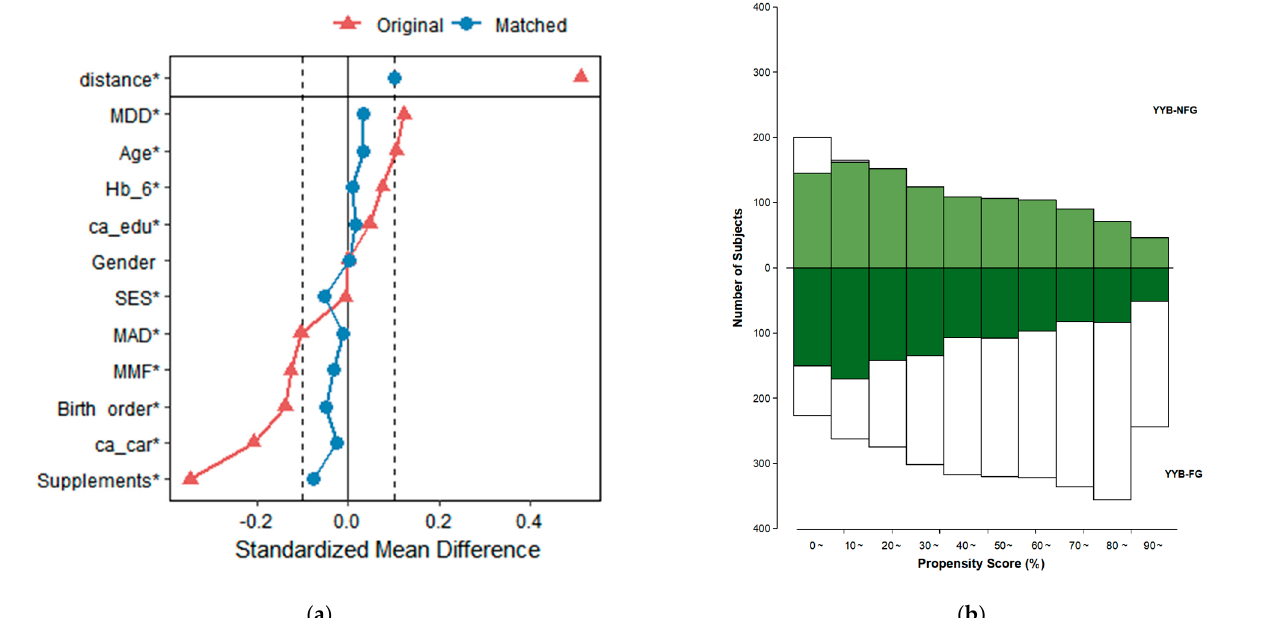
Figure 2. Assessment of covariate balance. ( a ) The Love plot shows changes in standardized mean difference before (red) and after (blue) propensity score matching. ( b ) The Mirrored Histogram shows the propensity score distribution and overlapping in unmatched (white) and matched (green) samples in the control (top) and treatment groups (bottom). SES: socio-economic status; ca_edu: education of caregivers; ca_car: career of caregivers; MDD: minimum dietary diversity; MMF: minimum meal frequency; MAD: minimum acceptable diet; Hb_6: hemoglobin levels of infants before YYB consumption at 6 months; YYB-FG: Ying Yang Bao feeding group; YYB-NFG: Ying Yang Bao non-feeding group. * Differences before and after propensity score matching were statistically significant at p <